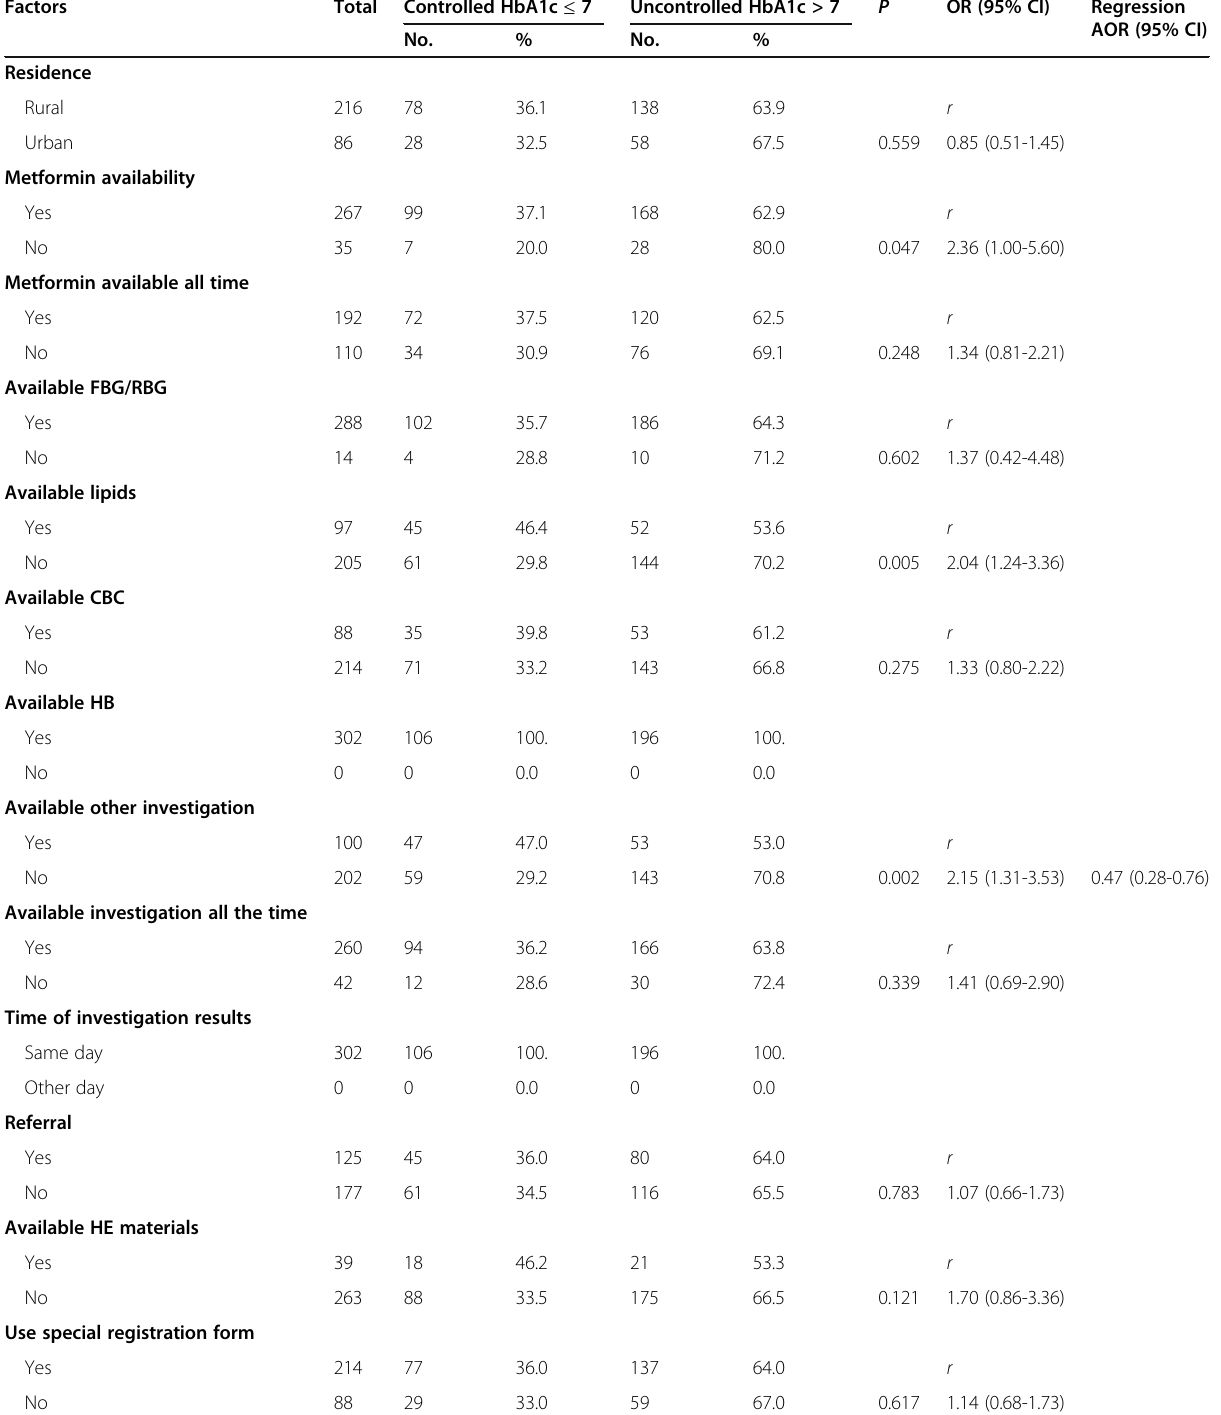
Table 2 Distribution of the studied subjects according blood glucose control and its relation to PHCFs infrastructure factors Factors